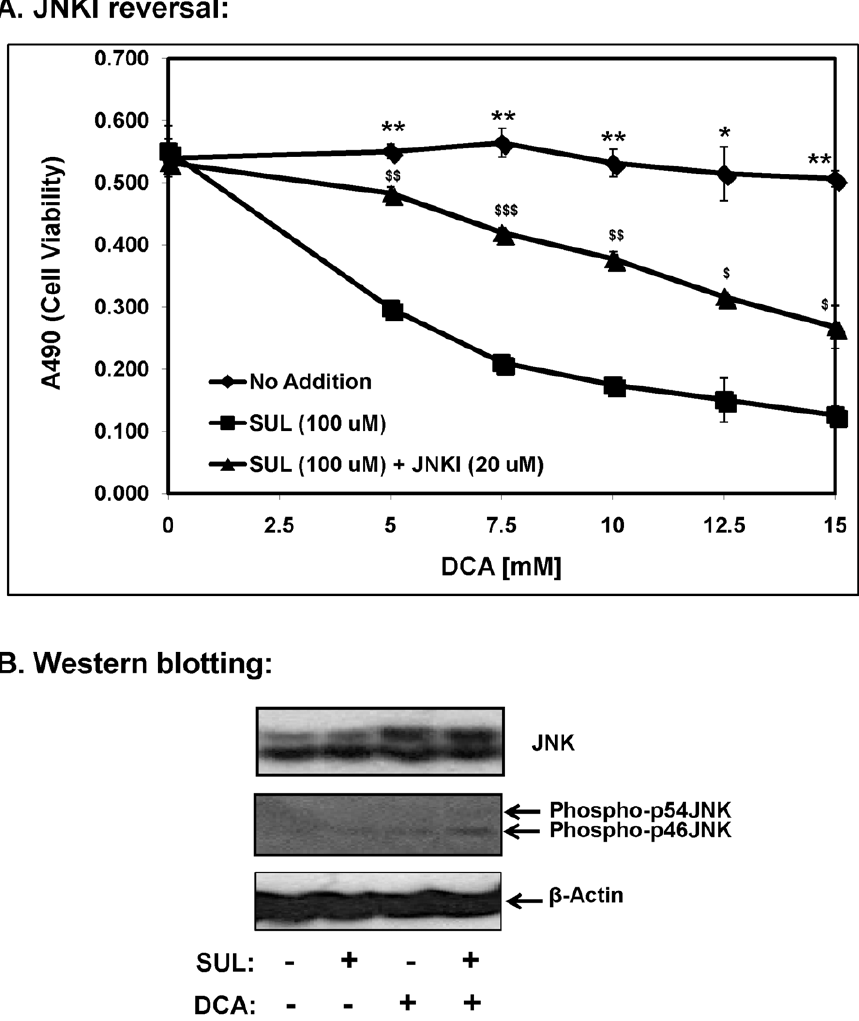
Figure 7. Combination of sulindac and DCA induced apoptosis involves JNK activation. A. SCC25 cells were treated for 48 h with sulindac (100 m M) and the indicated concentrations of DCA and where indicated 20 m M of the JNK inhibitor, SP600125. ¤ , No drug; & , sulindac; m , sulindac and SP600125. The cell viability was monitored by MTS assay as mentioned in the Methods. Error bars are standard error of the mean (SEM) expressed as % of the mean value of quadruplicates from a representative experiment. See text for details. Statistical analysis between ¤ , No addition and & , Sul; *p , 0.05, **p , 0.005, ***p , 0.0005. Statistical analysis between & , Sul and m , sulindac and JNKI; $ p , 0.05, $$ p , 0.005, $$$ p , 0.0005. B . Representative western blots depicting the effect of sulindac and DCA on the levels of total JNK, phopsho-p46JNK and phopsho-p54JNK. b -actin levels were used as an internal control. Cytosolic fractions from SCC25 cells were isolated at the 12 h time point and the levels of JNK and phospho- JNK were determined by western blotting. In the SCC25 cell line, total JNK showed two distinct bands at 46 and 54